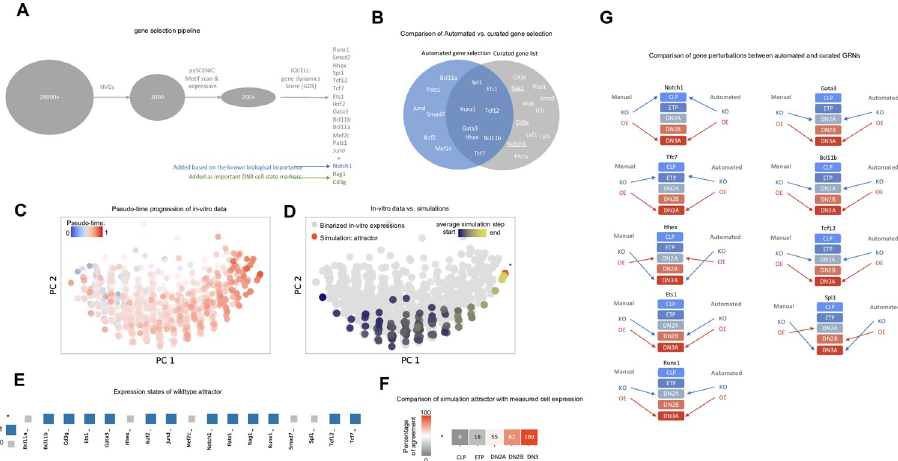
Fig 5. Constructing mouse early T-cell GRN based on automated TF selection pipeline. (A) Overview of TF selection procedure. After selecting HVGs, IQCELL uses pySCENIC to select active regulons (TFs and their effectors), and finally IQCELL uses GDS to rank and select TFs for the final list. We have added Notch1 for its known biological importance and Rag1 and Cd3g as biological markers of DN3 stage to the list. (B) Comparison of automated vs curated TF selection show that the TF selection pipeline captures 8 of 14 genes in the curated gene list. (C) The PCA plot of the binarized scRNA-seq data color-coded with the pseudo-time values attributed to each cell. The binarization is performed by clustering the scRNA-seq expressions into expressed or not expressed levels. (D) The PCA plot of the simulated developmental trajectories are overlaid on the binarized scRNA-seq. The detected attractor is colored red and marked by star ( � ). The simulated data is color coded by the value of average simulation step (average distance to the attractor of simulation). (E) Expression states of the GRN model steady state attractor. Genes that are expressed (1) and not expressed (0) are represented with blue and grey squares, respectively. (F) Percentage of similarity between the attractor (vertical axis) and binarized microarray expression profiles of CLP, ETP, DN2A, DN2B, and DN3A cells (horizontal axis) [38]. The average agreement between two random states is 50%. (G) Comparison of gene perturbations between automated and curated GRNs show 17 matches of the predicted sates out of 18